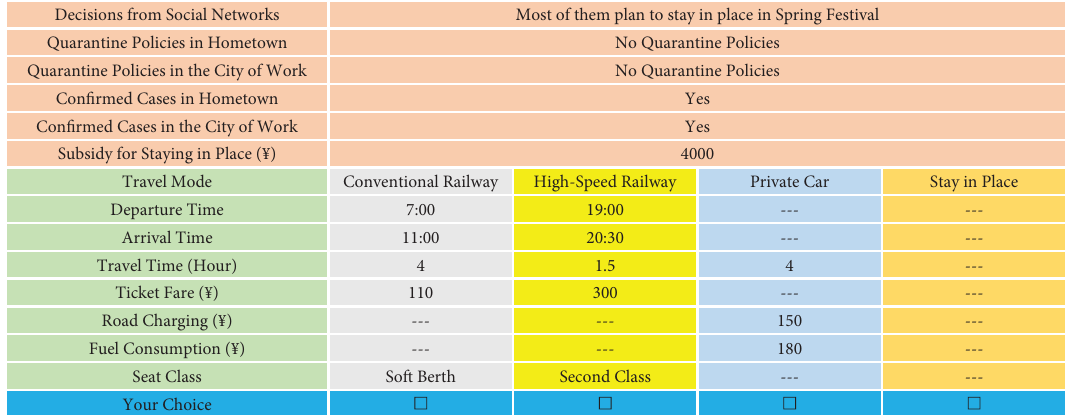
Figure 2: An example of the stated choice tasks (translated from Chinese).